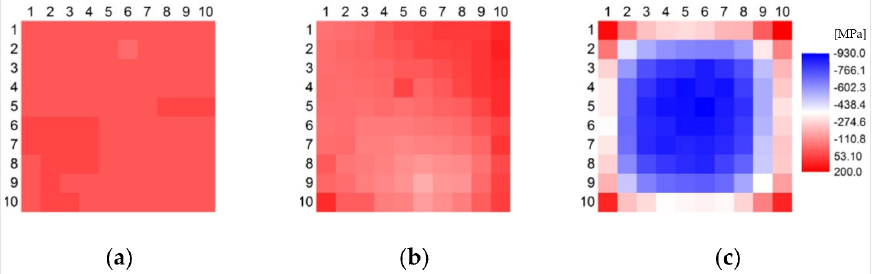
Figure 12. Stress distribution at − 50 ◦ C, on a Si_Unmounted chip (panel a ), A_AuSn_p sample ( b ), and A_AuSn sample ( c ).